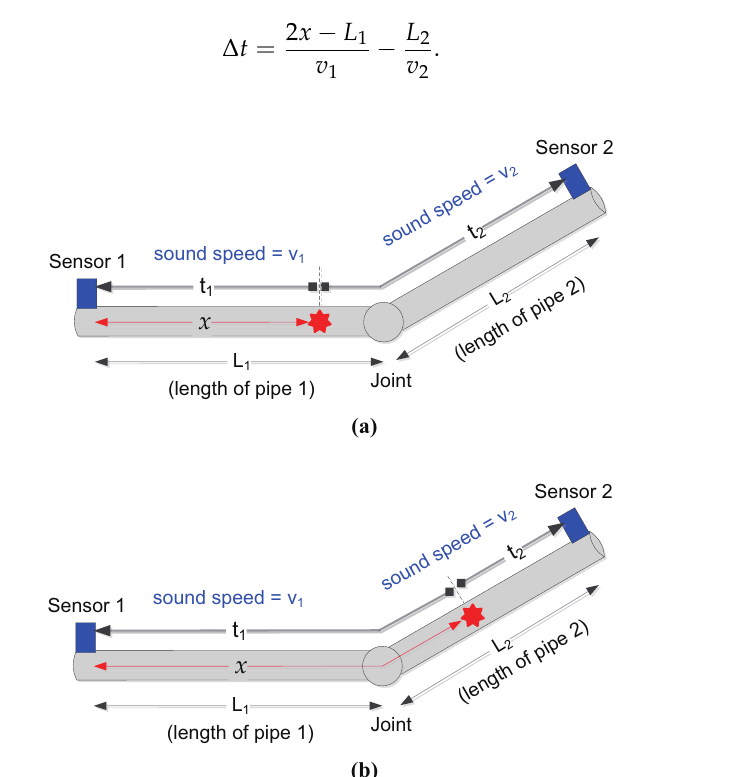
Figure 1. Leak location estimation using the time difference of signals received at sensors, when two different pipes are connected: ( a ) when pipe 1 has a leak; ( b ) when pipe 2 has a